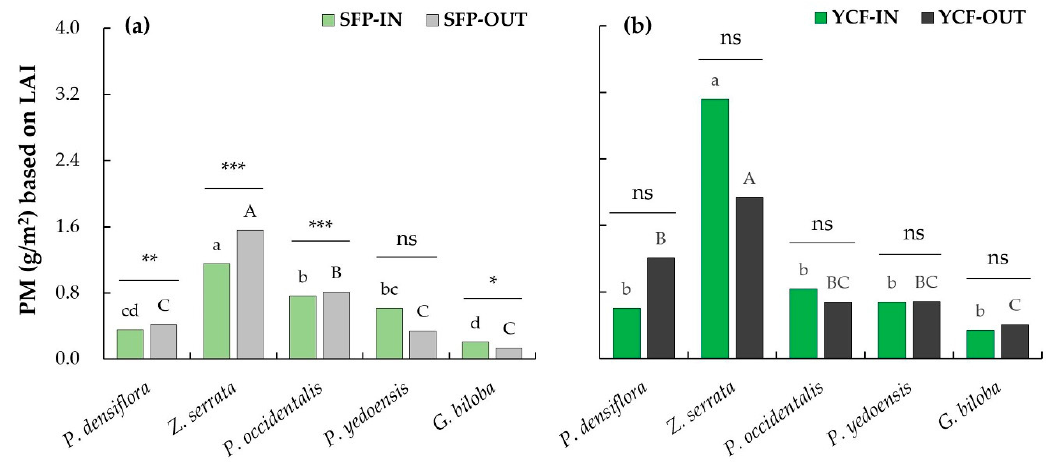
Figure 4. The amount of PM adsorption based on LAI of five tree species in urban forests and roadsides of ( a ) Seoul Forest Park (SFP-IN, SFP-OUT) and ( b ) Yangjae Citizen’s Forest (YCF-IN, YCF-OUT). Each bar represents the mean of nine replicates. Light green bars, SFP-IN; grey bars, SFP-OUT; green bars, YCF-IN; black bars, YCF-OUT. Di ff erent lowercase letters mean significant di ff erences among tree species within each SFP-IN and YCF-IN, while di ff erent uppercase letters mean significant di ff erences among tree species within each SFP-OUT and YCF-OUT (Duncan’s multiple range after one-way ANOVA). Asterisks represent significant di ff erences between urban forests and roadsides (i.e., SFP-IN and SFP-OUT; YCF-IN and YCF-OUT) within each site (paired t -test, * p < 0.05; ** p < 0.01; *** p < 0.001; ns, not significant).